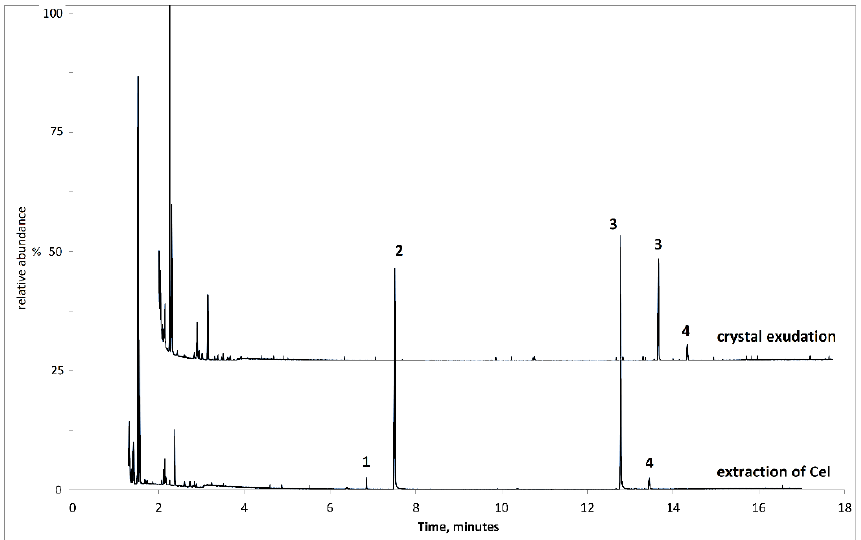
Figure 5. GC analysis of toluene extraction of a CA sheet, and that of solved crystals taken from the surface of the sheet. Peaks labelled, 1: butylated hydroxy toluene, 2: diethyl phthalate, 3: triphenyl phosphate, 4: diethyl hexyl phthalate.